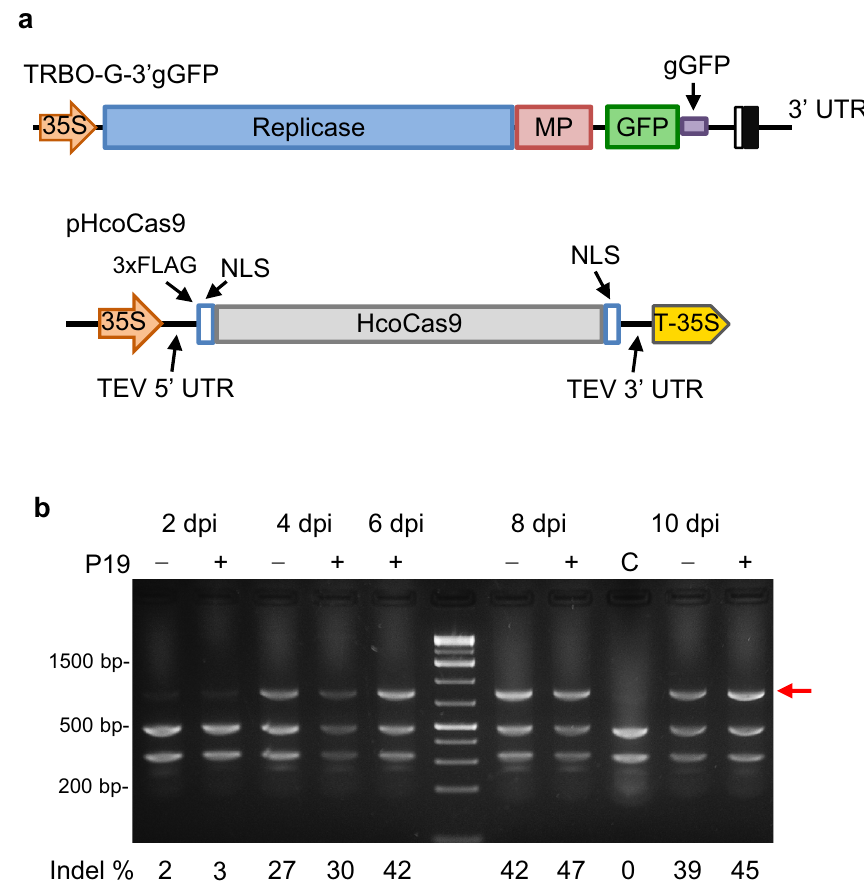
Figure 2. Indel analysis of Cas9/sgRNA using P19, a viral RNA silencing suppressor. ( a ) The TRBO-based construct used to deliver the gGFP (TRBO-G-3 ′ gGFP). The pHcoCas9 construct of Fig. 1 is also shown here for convenience of reference. ( b ) Indel analysis time course experiment using a Bsg I restriction digest assay of 16c transgenic plants co-infiltrated with pHcoCas9 and TRBO-G-3 ′ gGFP, with and without P19. Treated tissues were sampled at 2, 4, 6, 8, and 10 dpi. The red arrow indicates indel-containing